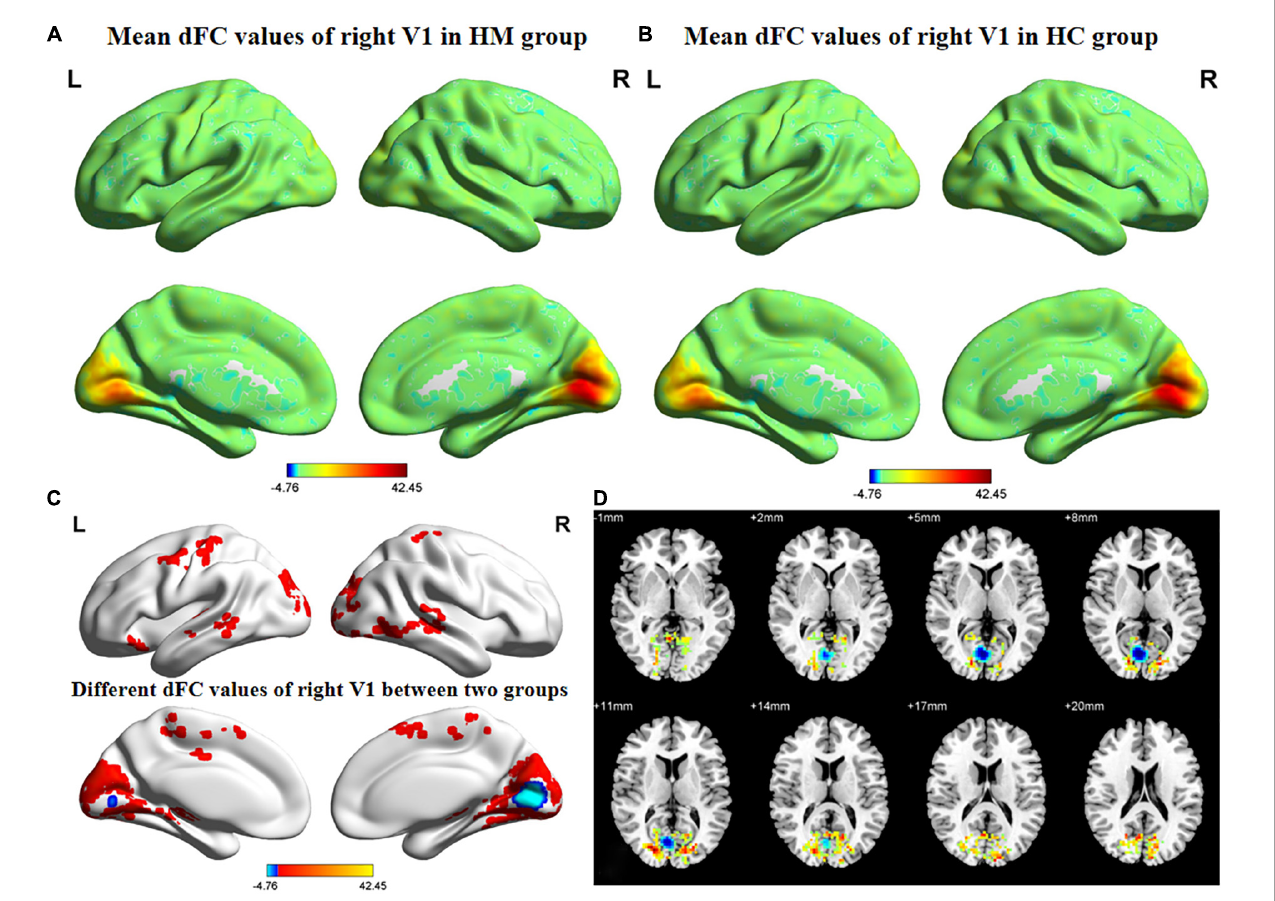
FIGURE4 Spatial of distributions of dFC patterns of the right V1 in HM patients and HCs. (A) Mean dFC values of right V1 in HM group; (B) mean dFC values of right V1 in HC group; (C) different dFC values of right V1 between two groups and (D) significant zdFC maps of right V1 differences among two groups. HCs, healthy controls; HM, high myopia; sFC, static functional connectivity; zdFC, z-values dynamic functional connectivity; L, left; R, right.